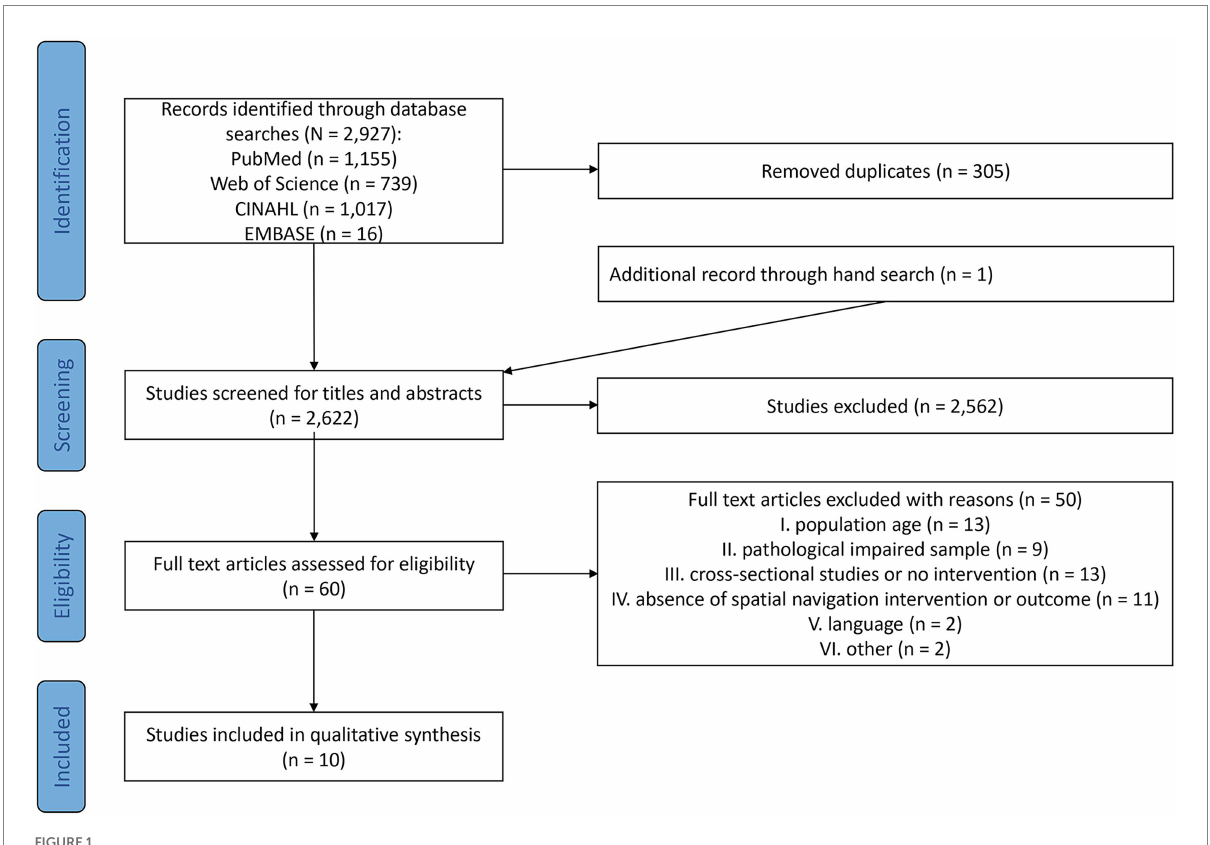
FIGURE 1 PRISMA flow diagram (according to Moher et al.,